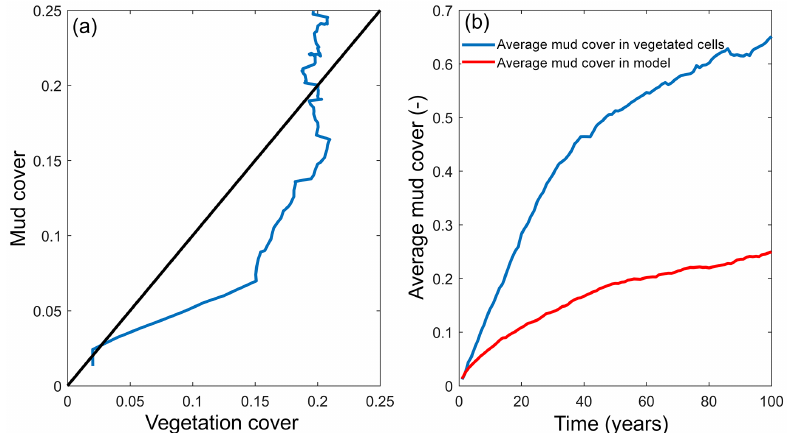
Figure 7. Interaction of mud and vegetation. (a) The development of the total mud and vegetation cover over time in the simulation where both are present, where the simulation begins in the origin of the plot. Black line indicates equality of mud and vegetation cover. (b) The average mud cover in vegetated cells and in the entire model, showing substantially higher cover in vegetated